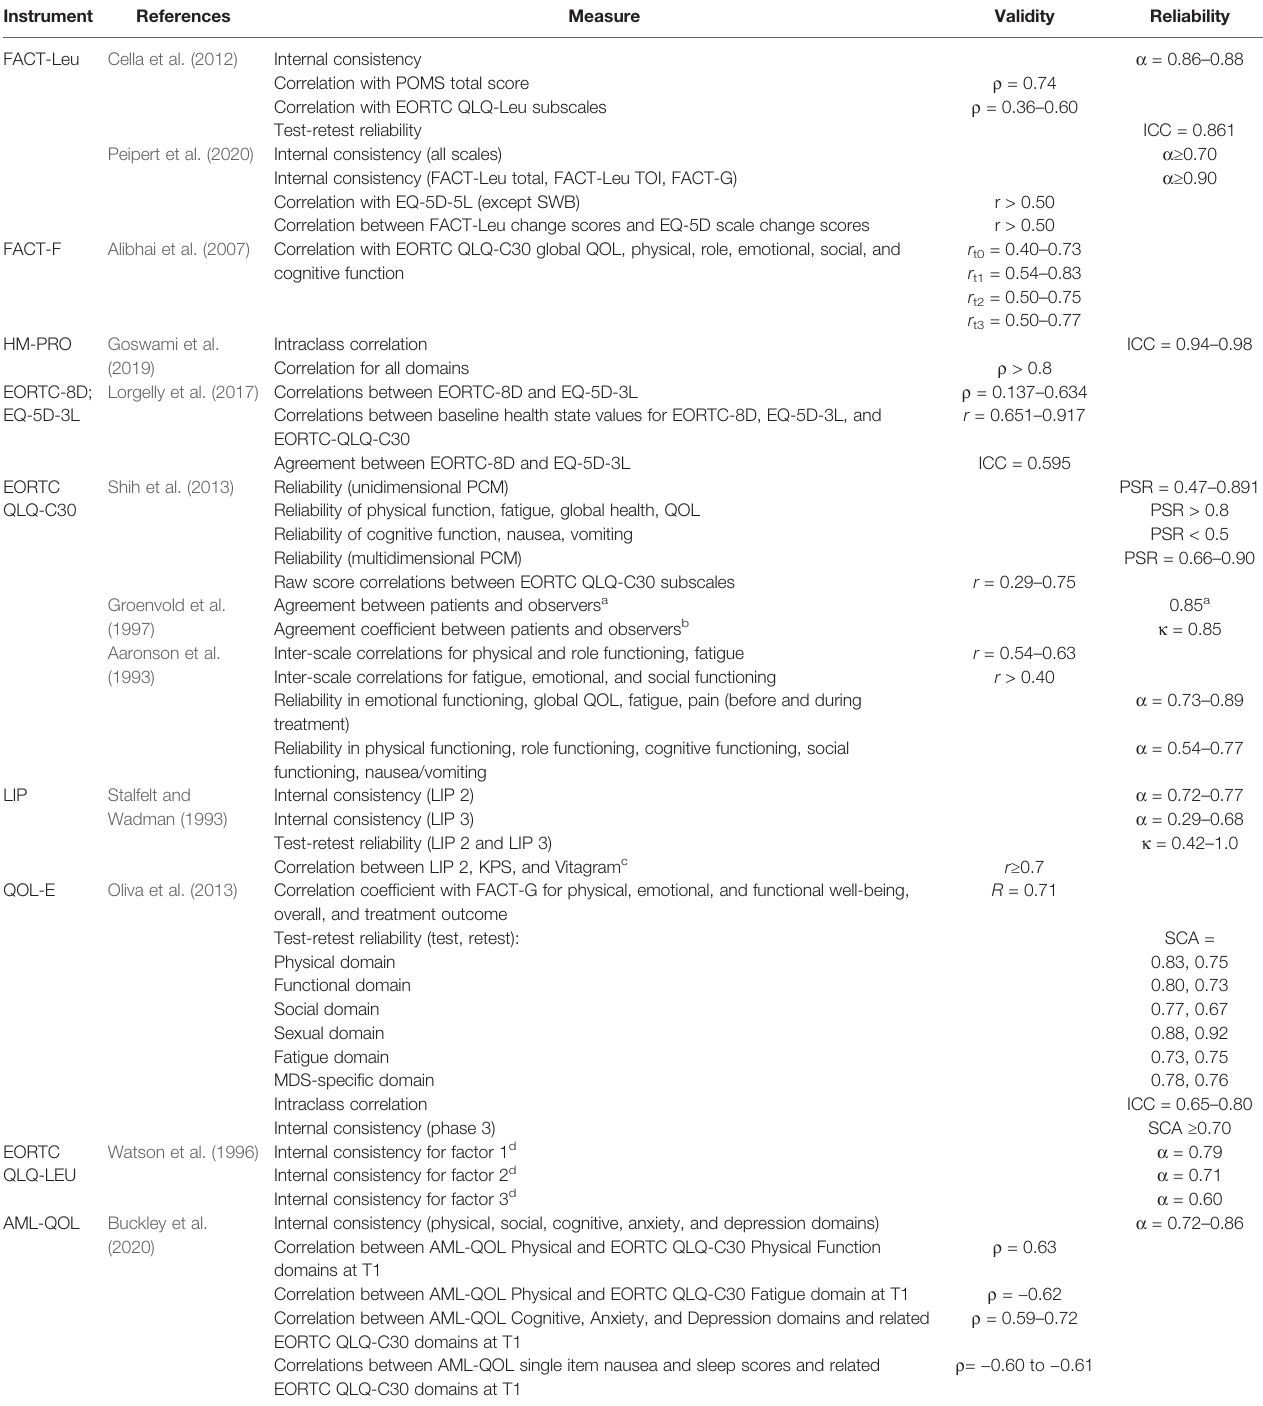
TABLE 3 | Psychometric properties of the instruments reported in published